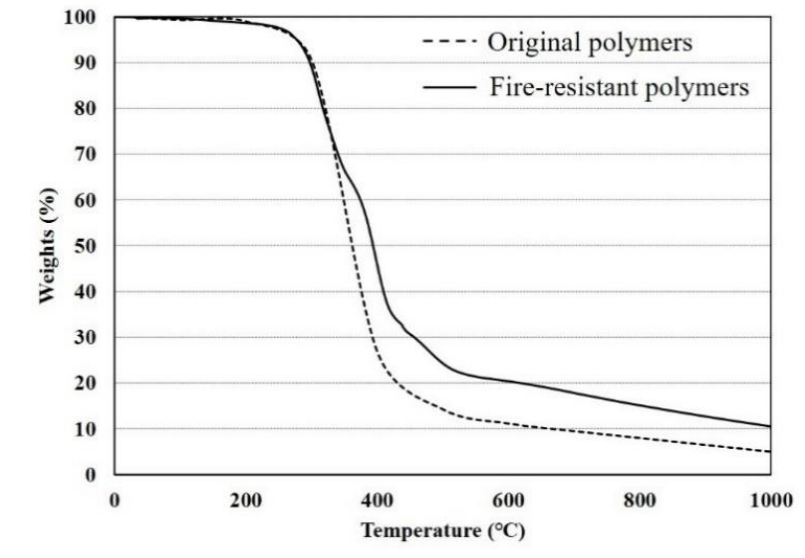
Figure 2. TGA results of original and fire-resistant polymers [11].